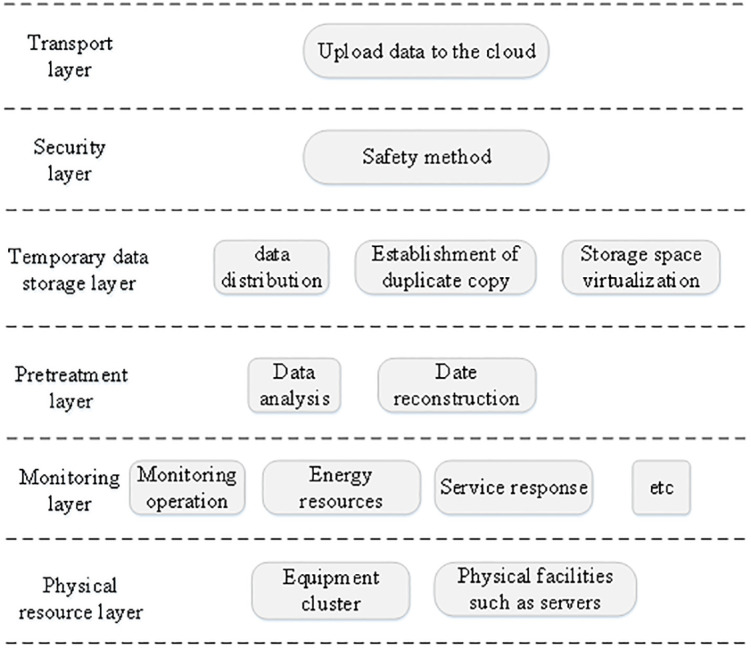
The hierarchy diagram of FG.